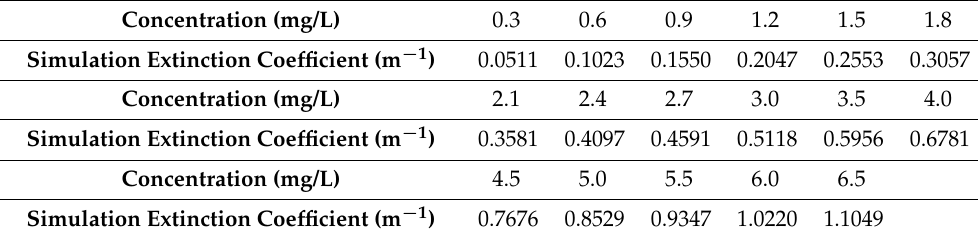
Table 9. Simulation extinction coefficient under different